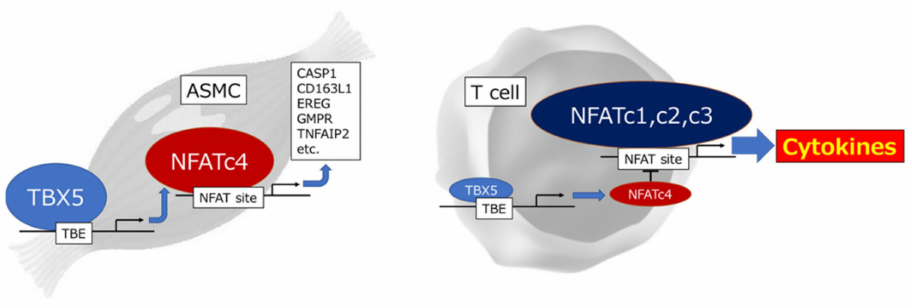
Figure 2. The different functional role of NFATc4 in aortic smooth muscle cells (ASMCs) and T cells through T-box factor 5 (TBX5)-mediated transcriptional regulation. CASP1; caspase 1, CD163L1; CD163 molecule like 1, EREG; epiregulin, GMPR; guanosine monophosphate reductase, TBE; T-box factor binding element, TNFAIP2; tumor necrosis factor-alpha-induced protein